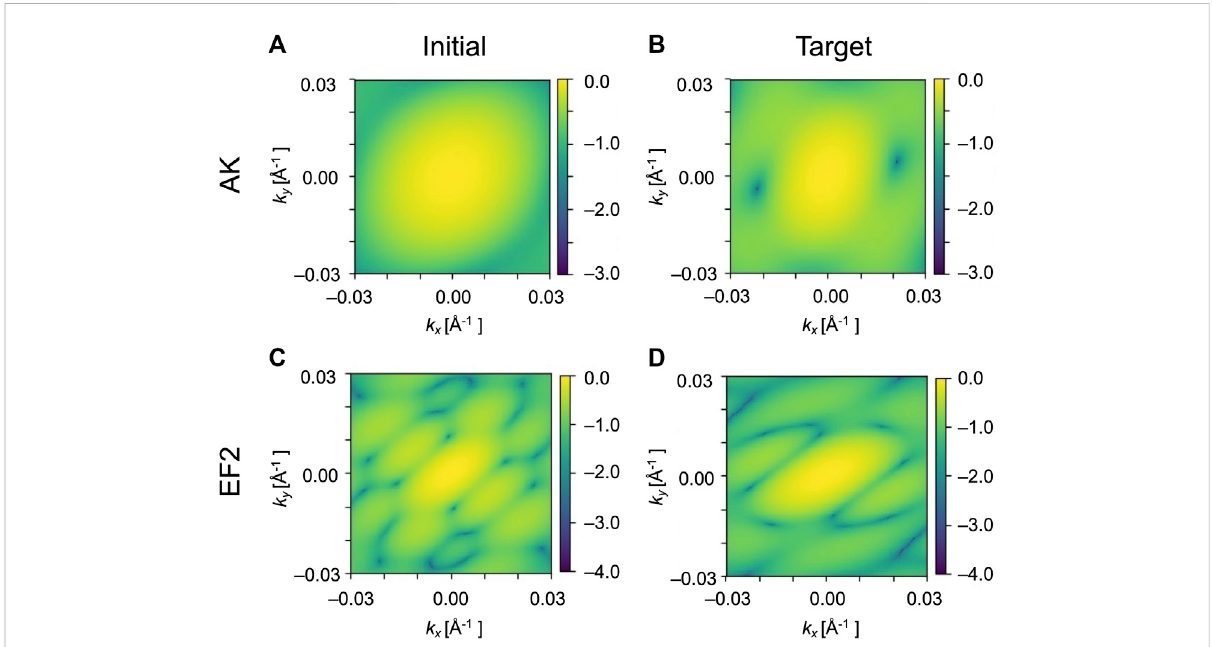
FIGURE 3 Simulated XFEL diffraction patterns of GMM models from structures shown in Figure 1. The patterns of the initial structure of AK (A) and of the target structure (B) . The patterns of EF2 for the initial (C) and the target (D) . k x and k y represent the wavenumbers of diffraction vectors (without 2 π ). The intensities in the diffraction images are shown as log 10 [ I ( k )/ I ( 0 )].